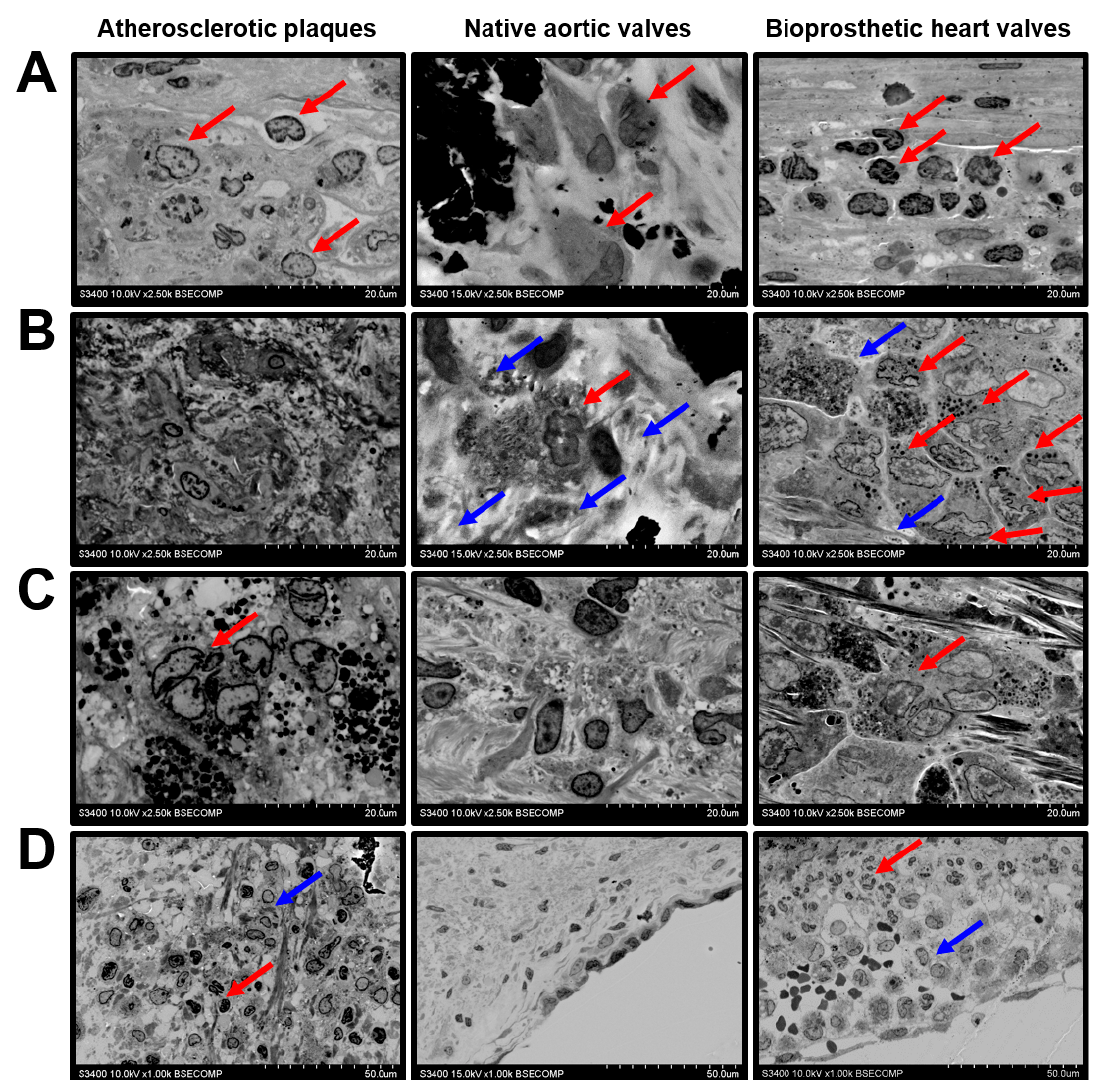
Figure 2. Macrophage diversity in the atherosclerotic plaques, calcified native AVs, and failed BHVs. ( A ) Canonical macrophages (indicated by red arrows) without cytoplasmic inclusions, magnification 2500 × . ( B ) Macrophages with electron-dense cytoplasmic granules (indicated by red arrows), surrounded by the degraded ECM (indicated by blue arrows), magnification 2500 × . Note the absence of this macrophage subtype in the atherosclerotic plaques. ( C ) Multinucleated giant cells with multiple electron-dense cytoplasmic inclusions (indicated by red arrows), magnification 2500 × . Note the absence of this macrophage subtype in the native AVs. ( D ) Combined neutrophil (indicated by red arrows) and macrophage (indicated by blue arrows) infiltration, magnification 1000 × . Note the absence of neutrophils in the native